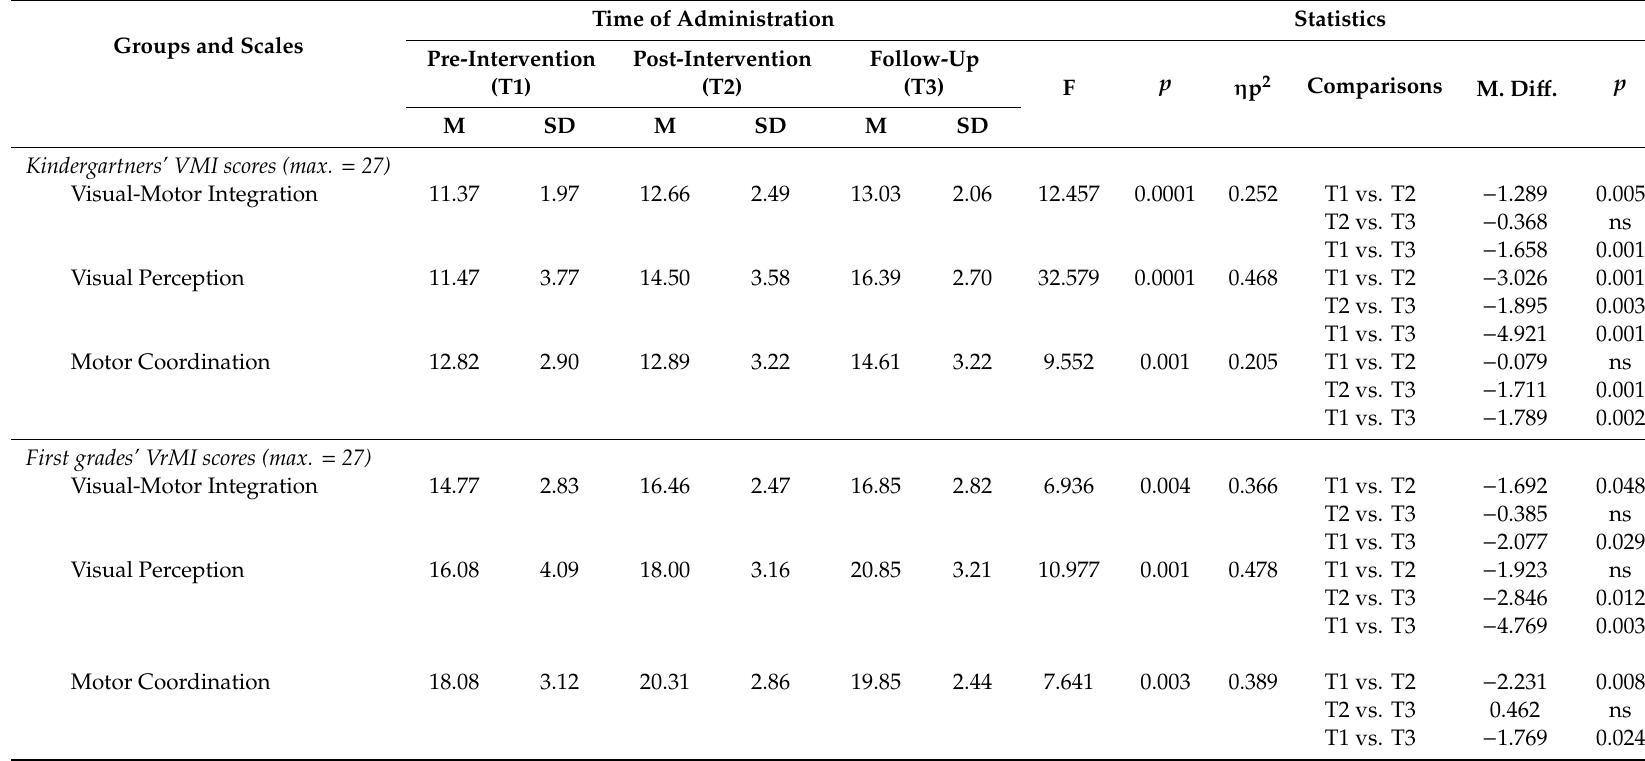
Table 4. Changes over time in kindergartners’ and first graders’ raw scores at the Beery Buktenica Visual-Motor Integration Test measured at T1, T2 and T3. Time of Administration Statistics Groups and Scales Pre-Intervention Post-Intervention